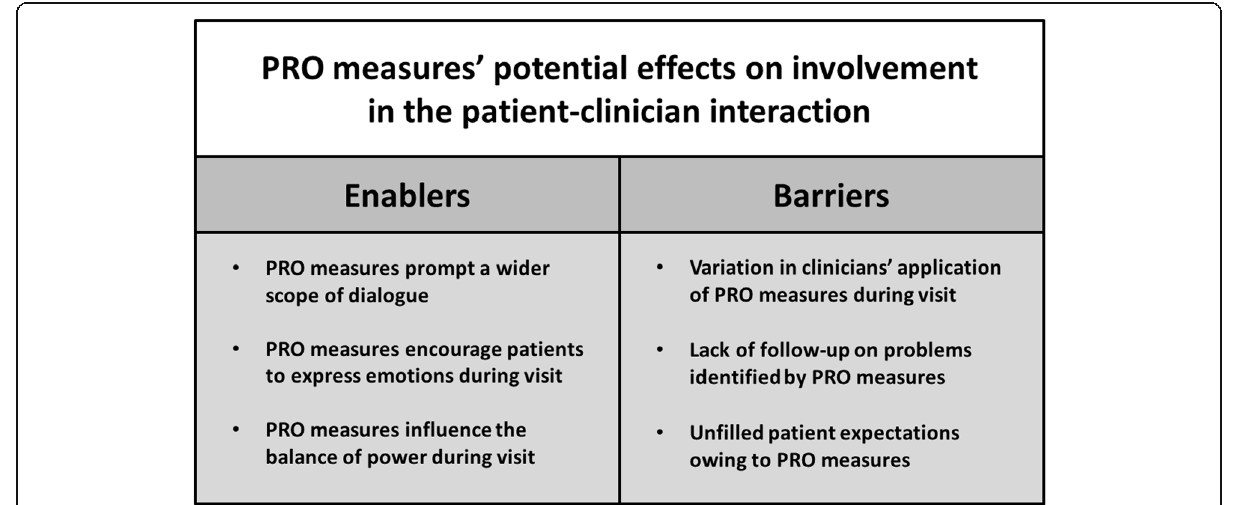
Fig. 1 PRO measures ’ potential effects on involvement in the patient-clinician